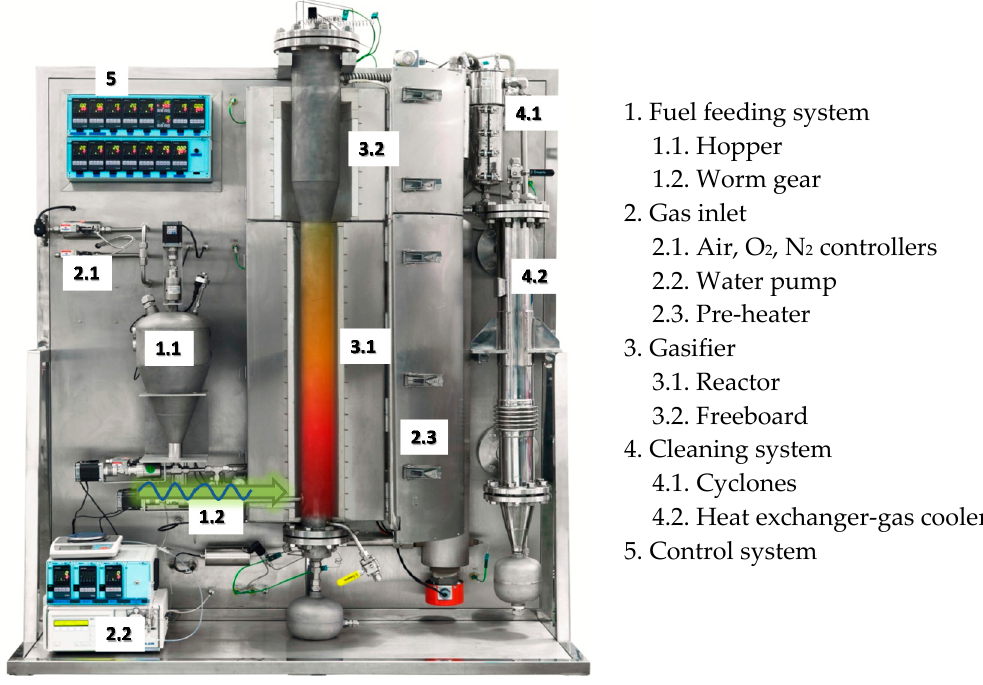
Figure 1. Photograph of the gasification plant with its main components.